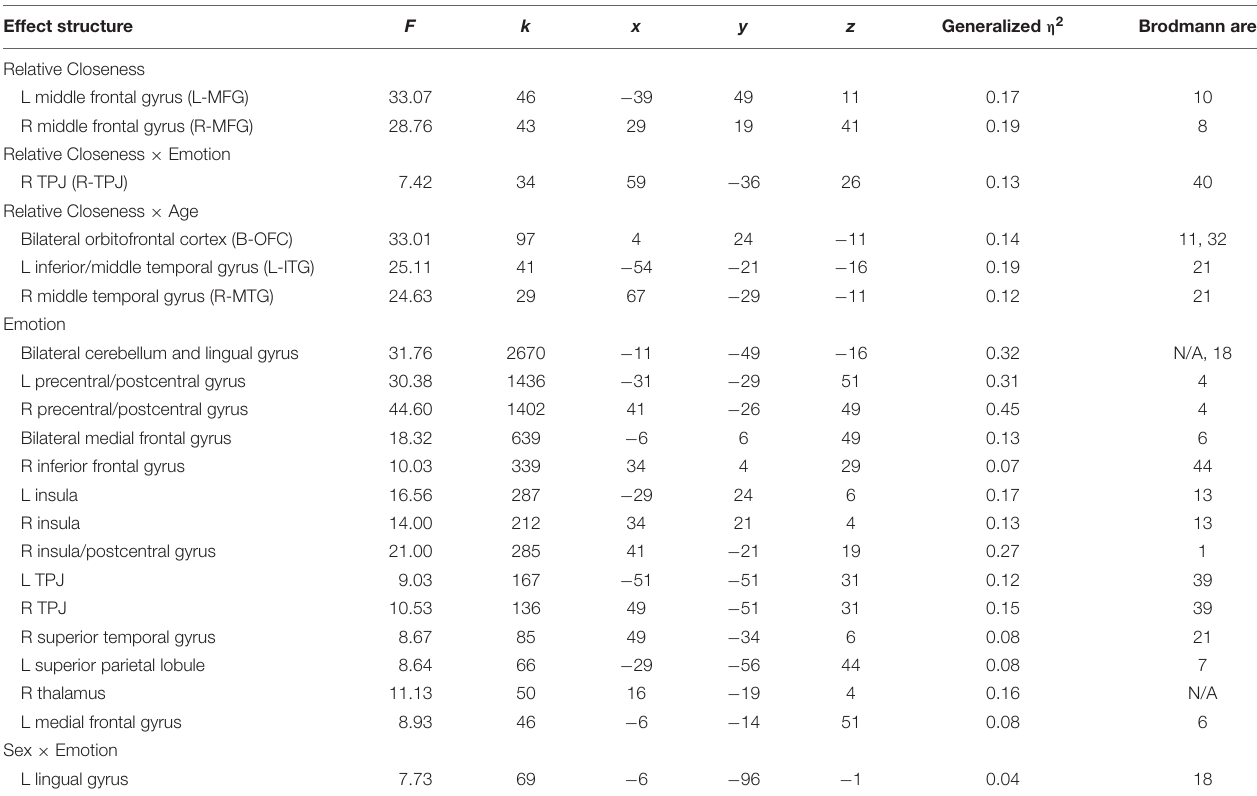
TABLE 2 | Effects of Relative Closeness, Age, and Emotion on neural activation to faces. Effect